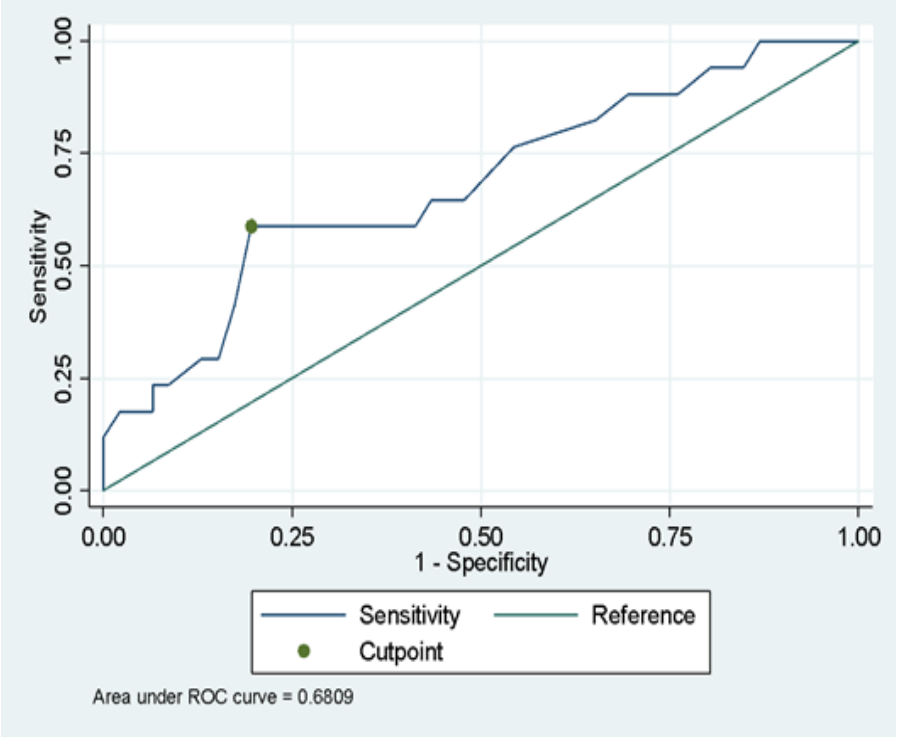
Figure 1. ROC analysis between MPV value and severity of SARS-CoV-2 infection [ROC: 0.6809, 95% CI (0.52664-0.83526)]. 95% CI (0.52664-0.83526)]. Table 3. Analysis of the calculated cut-off point for MPV as a predictor of severity of SARS-CoV-2 infection.